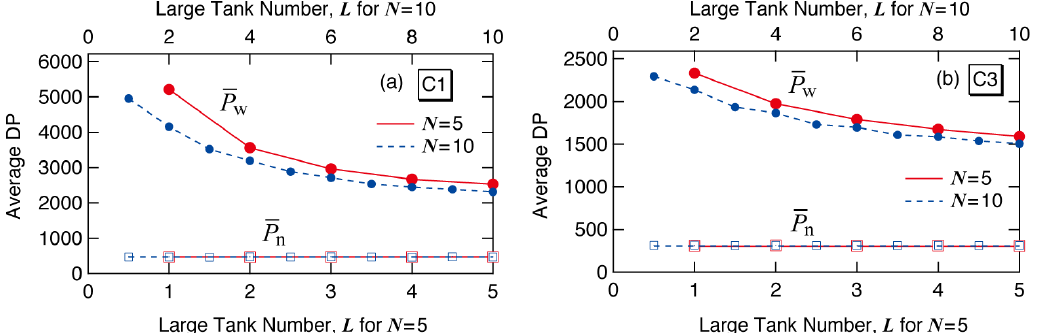
Figure 12. MC simulation results for the number ( P polymerization of the polymers formed for conditions ( a ) C1 and ( b )